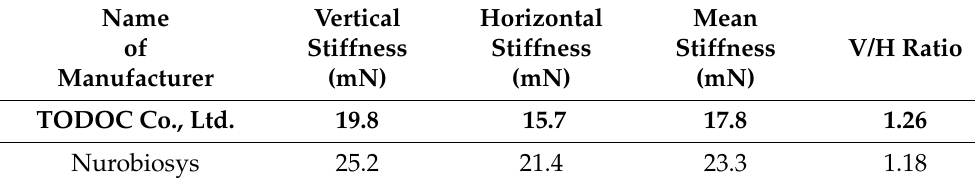
Table 1. Electrode stiffness measurement